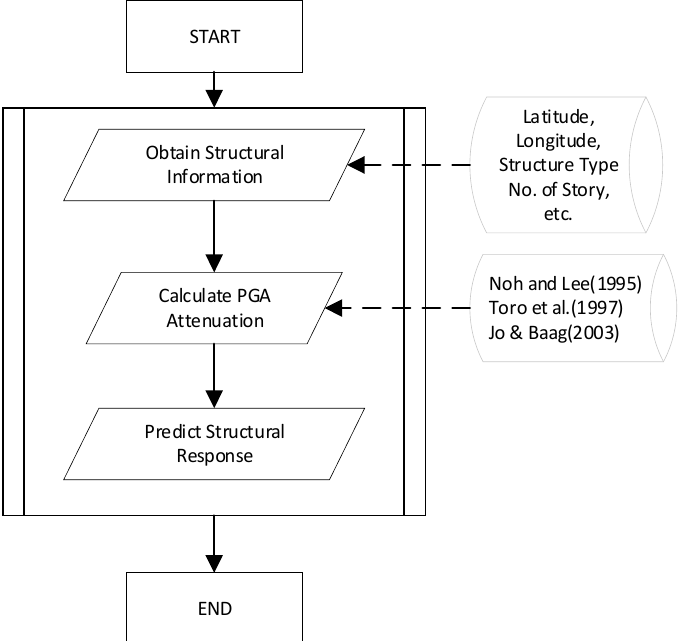
Figure 10. Process for the prediction of the structural response considering the reduction in magni- tude for seismic activities.